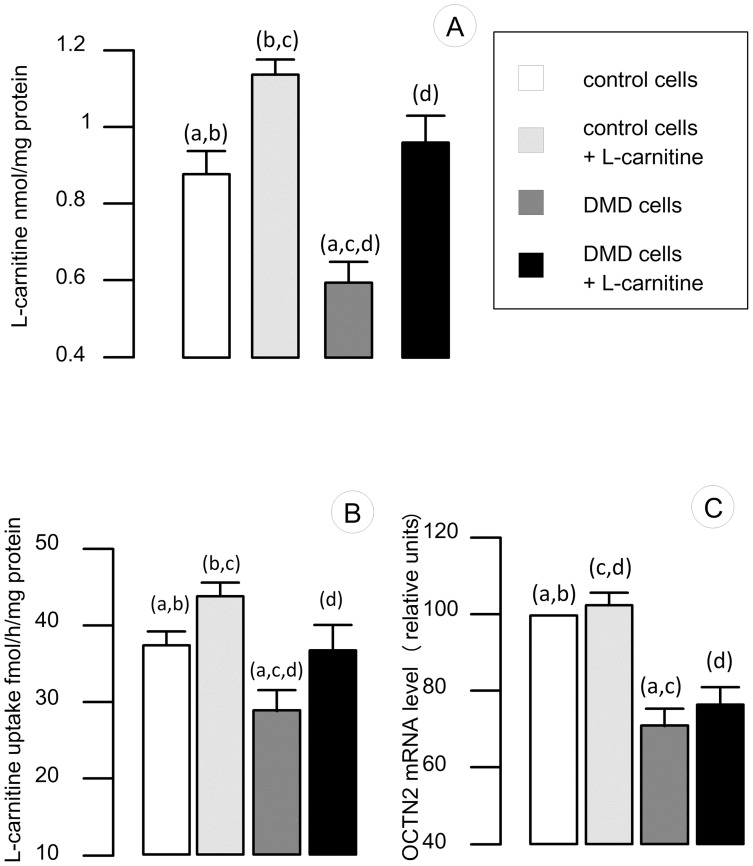
L-carnitine related parameters in muscle cells. L-carnitine content, transport and OCTN2 mRNA levels were determined in control and DMD patient cell treated (or not) with 500 µM of L-carnitine.Results are presented as histograms. Each histogram represented the means +/− sem of 7 independent determinations. Control cells were represented by white histogram, control cells treated with L-carnitine by light grey histogram, DMD cells by dark grey histogram and L-carnitine treated DMD cells by a black histogram. Statistical differences between samples are indicated by letters on top of the histograms. Two identical letters placed indicated a significant difference between the two samples (p<0.05). (A) L-carnitine content was determined in cultured muscle cells and L-carnitine content was expressed in nmol per mg of protein. (B) L-carnitine uptake was determined in cultured cells and expressed in fmol of L-carnitine transported per hour and per mg of protein. (C) OCTN2 mRNA levels were determined by RT-q-PCR. The amount was normalized and expressed relatively to control cells.